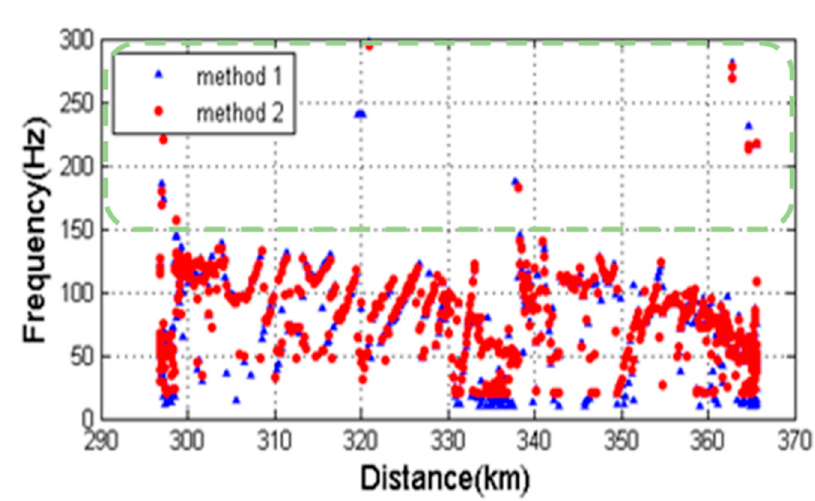
Figure 5. The frequency analysis of vibration acceleration on the bogie with the train traveled position (Distance), which is indicated by the number of kilometers of distance away from the starting point of the track: The acceleration measured in the bogie is shown to be concentrated in the range of 150 Hz or less in case of the bogie (the difference of vibration acceleration is apparent in the green color dash area of Figures 4–5).